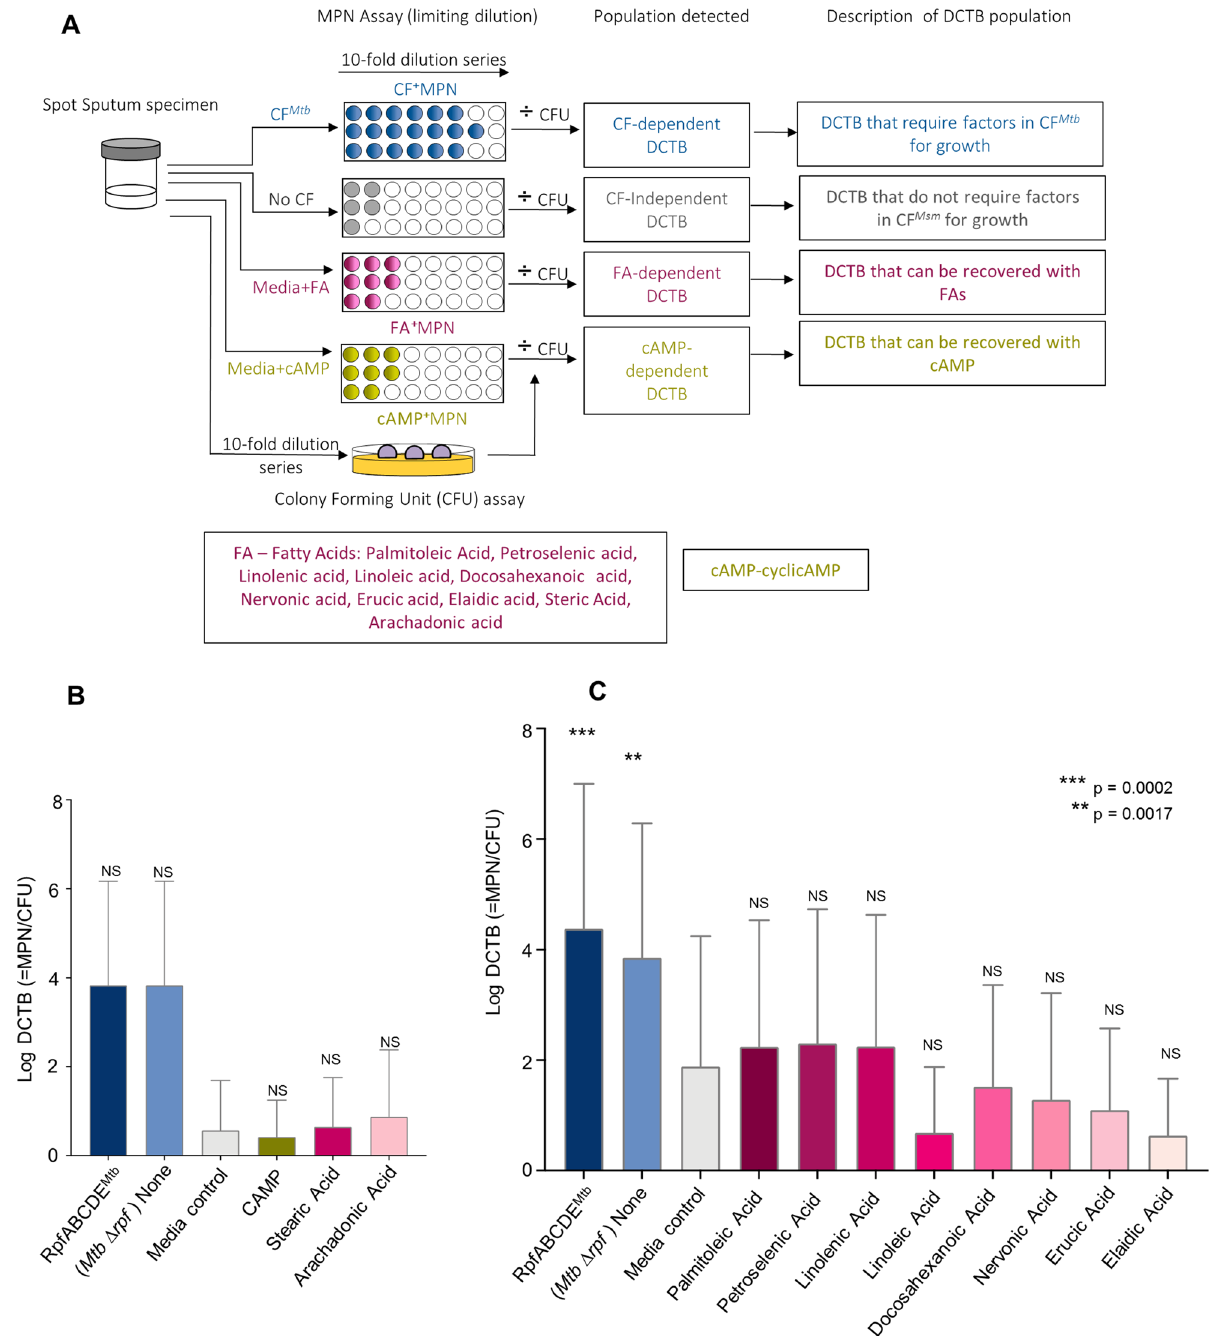
Figure 5. Bacterial yield in DCTB assays using CF containing Fatty acids and cyclic-AMP. ( A ) Assessment of DCTB recovery from sputum cultures using CF, fatty acid and cyclic-AMP (CAMP) supplementation. DCTB were detected using the MPN limiting dilution assay. For comparison, CF containing and deficient in Mtb Rpfs was used to compare the growth stimulatory effects of fatty acids and cAMP. To control for the effect of CF in growth stimulation, fresh Middlebrook media was used, which standardly contains oleic acid. To obtain the DCTB count, MPN values (with or without CF) were divided by CFU counts, which depict conventionally culturable bacteria. ( B ) Histogram depicting mean DCTB counts from MPN assays supplemented with standard media containing cAMP or select fatty acids. Statistical comparisons were conducted between CFs and the no CF or cAMP/fatty acid assays. There was an increase in bacterial recovery from MPN assays containing CF, which was not significant, most likely due to the small samples size (n = 4), no significant increase in DCTB recovery was noted in the media control and cAMP or fatty acid assays. Error bars depict the standard error of the mean. ( C ) Histogram depicting mean DCTB counts from assays using CF from Mtb and standard media supplemented with fatty acids . The mean DCTB counts were compared to that obtained from the media controls assay using a Wilcoxon test to determine the growth stimulatory affect of fatty acids. P-values depict the comparison of the CFs to the no CF or fatty acid assays. Graphs were generated using Graphpad Prism software, Version